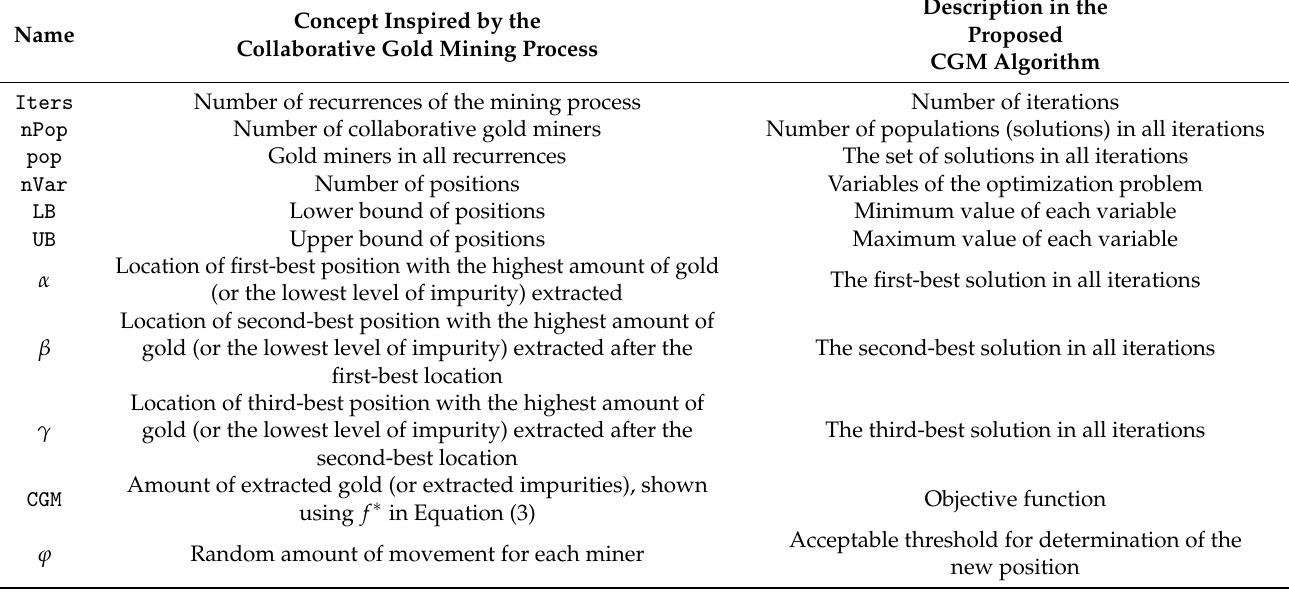
Table 1. Important variables and parameters used in the CGM